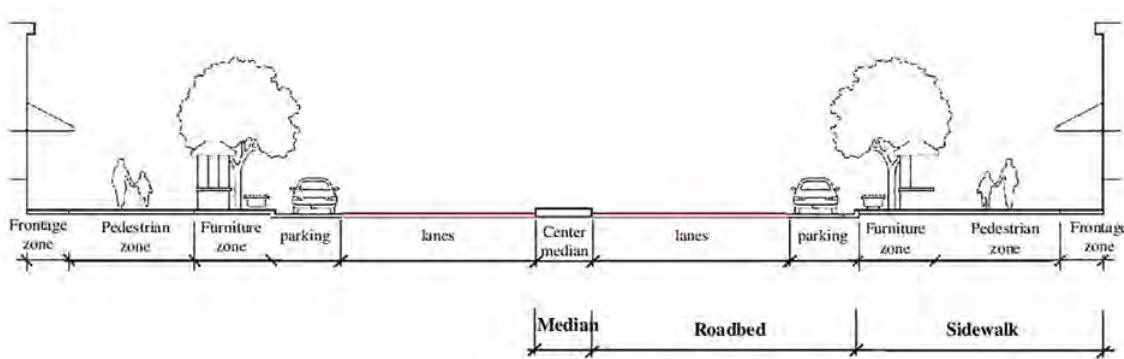
Figure 5. The street’s parts -road